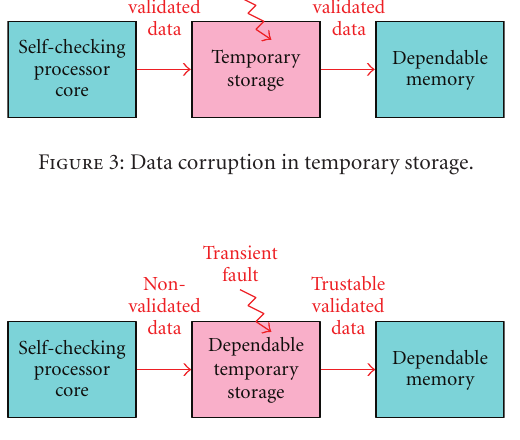
Figure 4: DTS protecting DM from